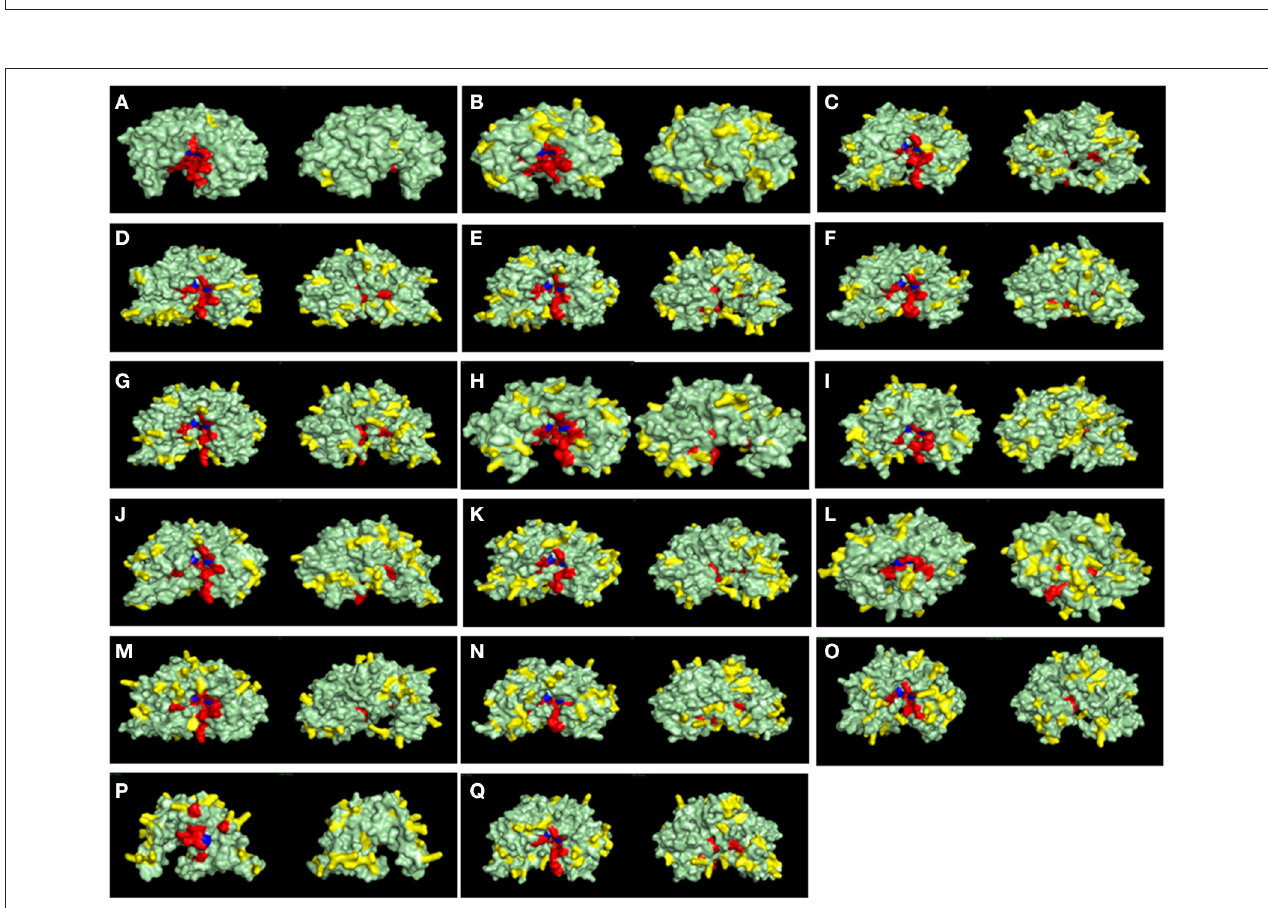
FIGURE 9 | Surface view of structural models of A1 peptidase sequences from Rhodnius prolixus and their human counterparts. Catalytic Aspartates are depicted in blue, and other active site residues are shown in red. Basic exposed residues are shown in yellow, and the rest of protein surface is shown in light green. Left panels are the active site (front) view, and right panels are the rear view of each model. (A) , Pepsin A; (B) , Cathepsin D; (C) , RPRC006698; (D) , RPRC012786; (E) , RPRC015079; (F) , RPRC015082; (G) , RPRC015076; (H) , RPRC012664; (I) , RPRC004171; (J) , RPRC006028; (K) , RPRC012785; (L) , RPRC006759; (M) , RPRC004330; (N) , RPRC014747; (O) , RPRC002479; (P) , RPRC012504; (Q) , RPRC012508.